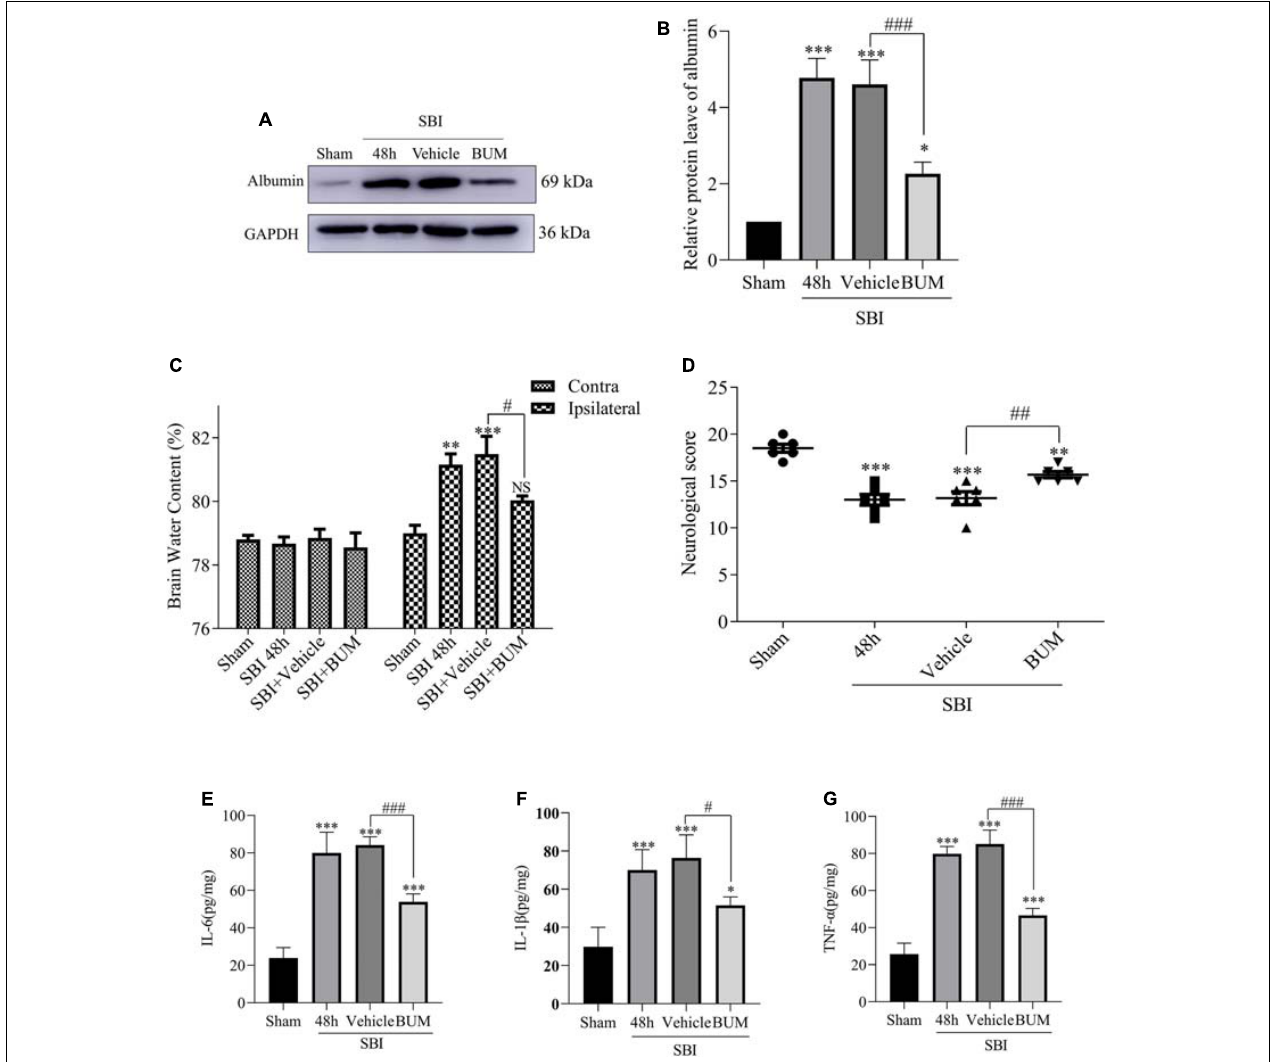
FIGURE 6 | Effect of BUM intervention on ELISA, brain edema and neurological score 48 h after SBI surgery. The protein expression levels of albumin (A,B) were measured to evaluate the effect of BUM intervention on peripheral cortex injury 48 h after SBI. Brain water content of the bilateral hemispheres of the study groups was determined using the wet-dry method (C) . Neurological behavioral scores in the SBI rats after BUM intervention (D) . The ELISA expression levels of IL-6 (E) , IL-1 β (F) and TNF- α (G) were assessed to determine the effect of BUM intervention on peripheral cortex injury 48 h after SBI. Statistical analyses were conducted using a K–W one-way ANOVA and the Student–Newman–Keuls post hoc test. n = 4 for each group. ** P < 0.01, *** P < 0.001, compared with the sham group. # P < 0.05, ## P < 0.01, ### P < 0.001, compared with the SBI + Vehicle group.